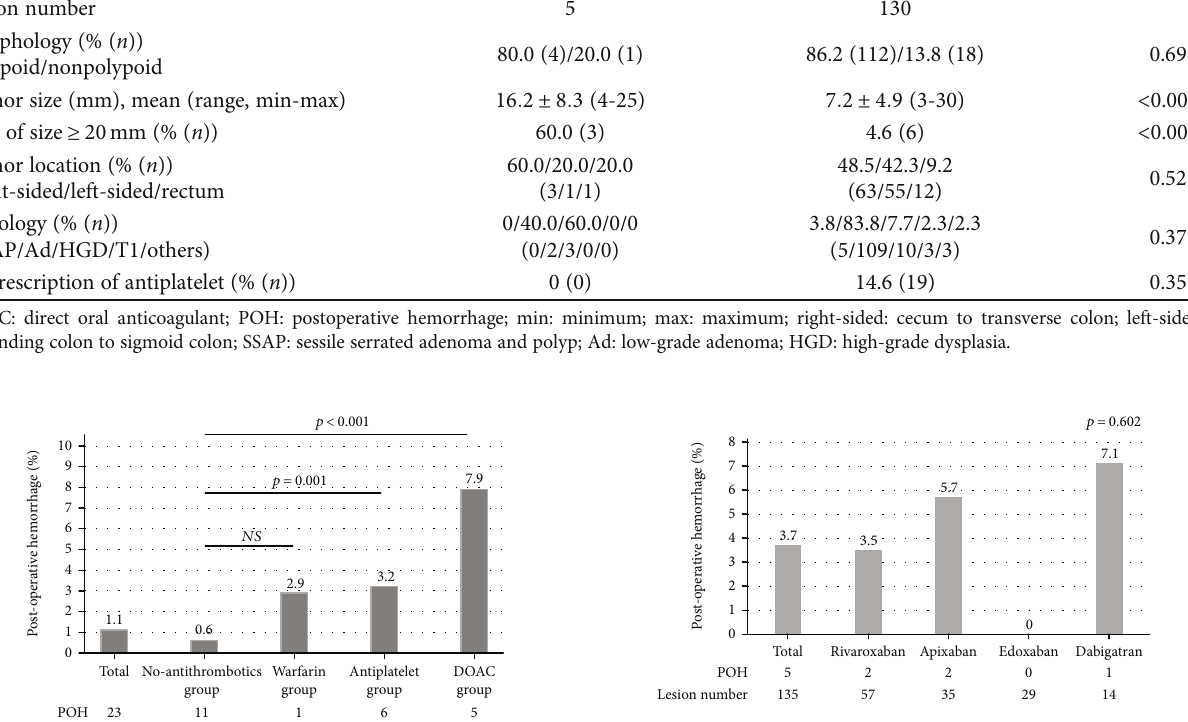
Figure 3: The rates of postoperative hemorrhage after endoscopic mucosal resection per lesion by each